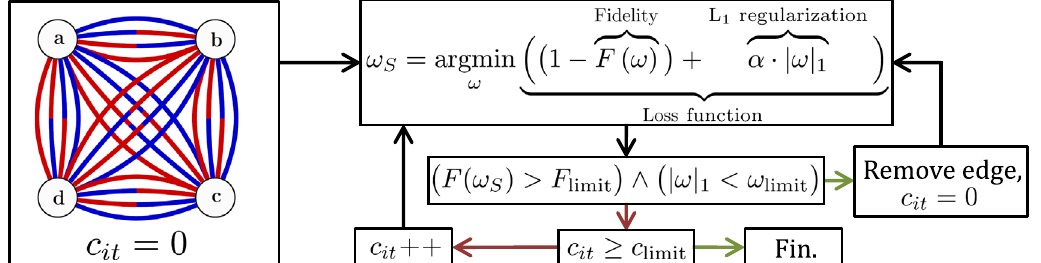
FIG. 2. Algorithm — T HESEUS : The initial graph contains all possible edges between each vertex, leading to j G j ¼ d 2 ½ n ð n − 1 Þ = 2 (cid:2) , where v 1 ( v 2 ) stands for edges (with n vertices and d different edge colors), each of them having an independent complex weight ω m 1 ;m 2 v 1 ;v 2 the first (second) vertex, and m 1 ( m 2 ) stands for the color of the edge close to vertex v 1 ( v 2 ).. The main step is a minimization of the loss function, which contains the quantum fidelity in terms of weights of the graph. Additionally, an L 1 regularization term controls the magnitude of the weights. If the weights identified by the optimization, ω , lead to fidelities larger than F , and the magnitude of the S limit weights is smaller than ω , then one edge of the graph is removed, and the optimization continues with the smaller graph. On the other limit hand, if the criteria are not fulfilled, the same graph is optimized (with different starting conditions) until the discovery of a suitable solution or the number of iterations exceeds c . The result of T HESEUS is a weighted graph that leads to sufficiently large fidelities, limit with a small number of edges. This topological optimization enables the scientific interpretation and understanding of